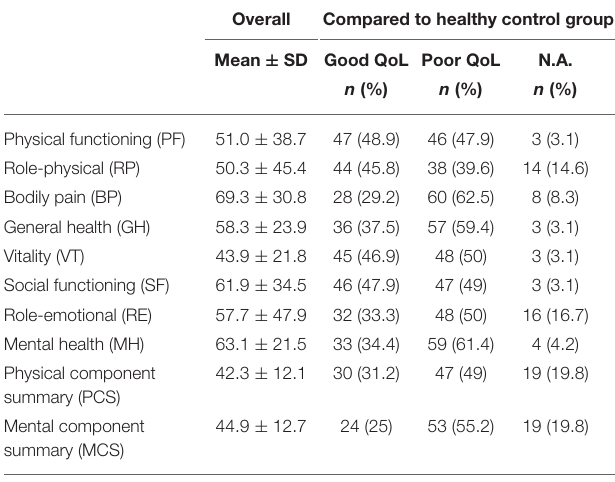
TABLE 2 | Results of SF-36 compared in overall and QoL in relation to comparable data set of a healthy control group ( n , number; %,